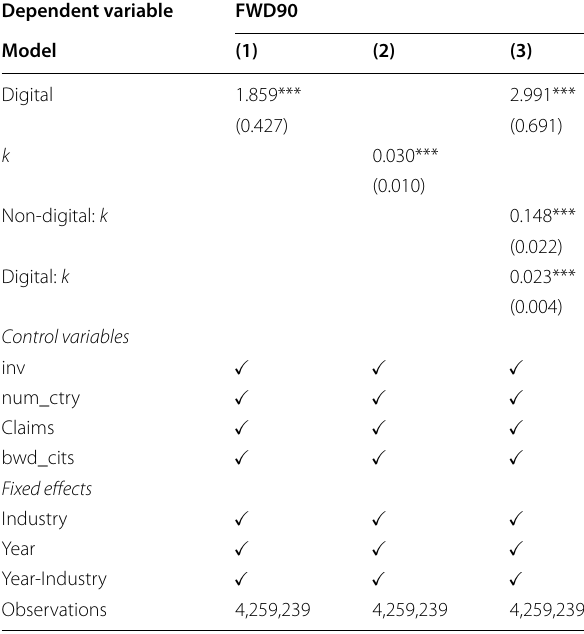
Table 1 Technological improvement rates and breakthrough